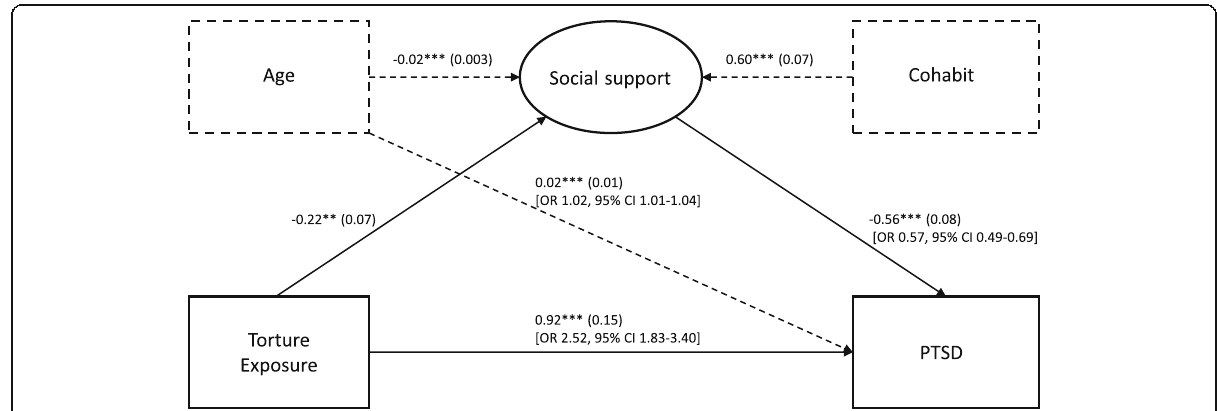
Fig. 2 Structural equation model of exposure to torture, PTSD and social support as a mediator. The structural weights are invariant across gender. The displayed estimates are unstandardized coefficients ( B ). The values in parenthesis denote robust standard error. ** p <0.01, *** p <0.001. Odds ratio and 95% Confidence Intervals are shown in square brackets